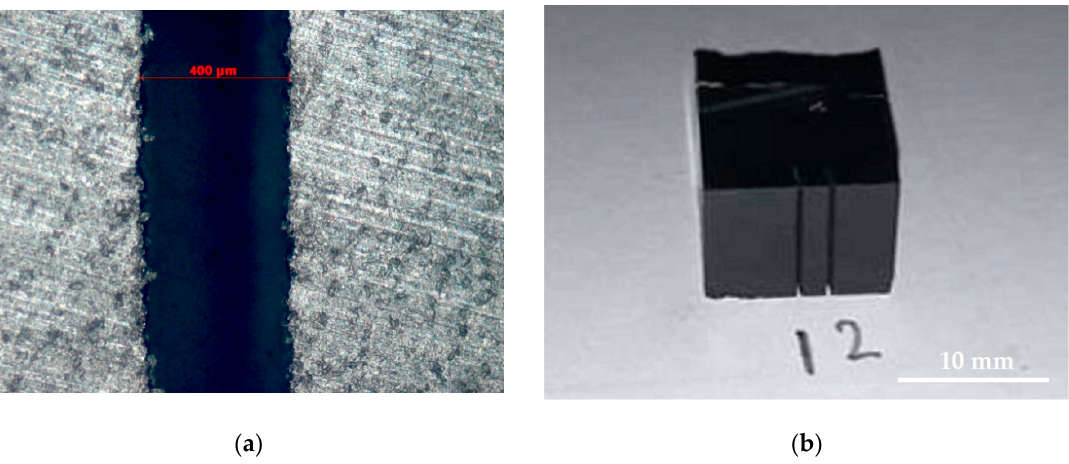
Figure 13. Cut slot in the Al 2 O 3 + 30%TiC nanocomposite sample after electrical discharge machining in water: ( a ) microscope picture, 50.0×; ( b ) general view.